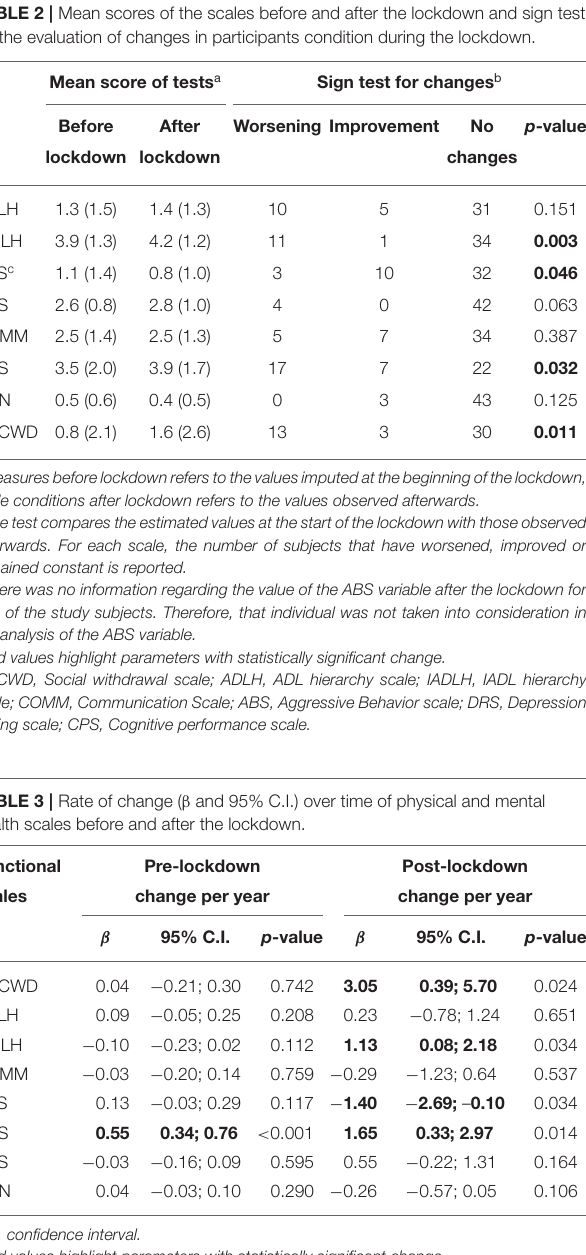
C.I., confidence interval. Bold values highlight parameters with statistically significant change. For all measures positive changes mean worsening and negative changes improvement in